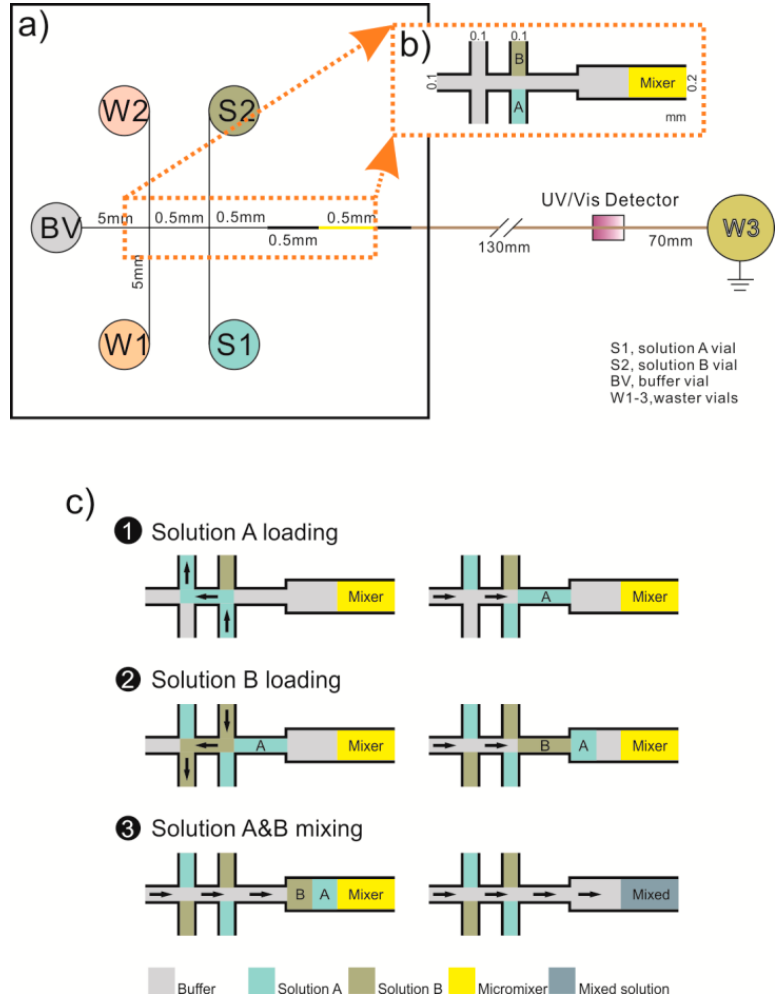
Figure 2. Schematic diagram showing ( a ) the developed polymethyl methacrylate (PMMA) microfluidic chip with ( b ) micromixer and ( c ) the sequential mixing steps.